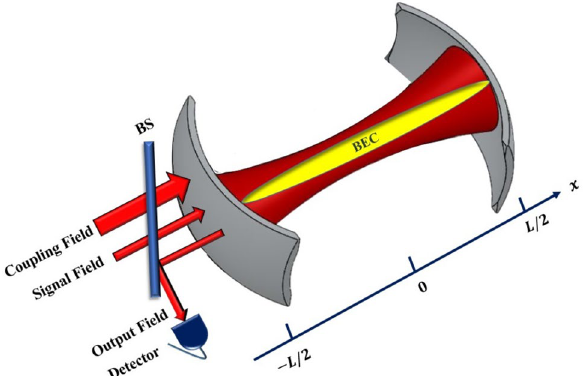
Figure 1. (Color online) A Fabry-Perot cavity containing a trapped BEC is driven by a strong coupling laser along its axis from the left mirror of the cavity where a weak input signal is also entered. The system behaves as an optical transistor that can amplify the input signal in the output which emanates from the left side of the